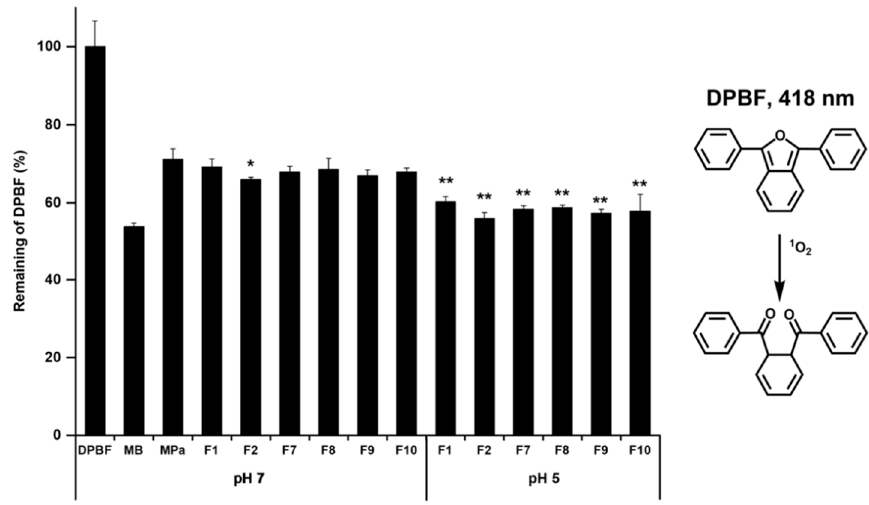
Figure 8. DPBF (50 µ M in DMSO) absorbance decay (%) for the 1 O 2 photogeneration efficacy of MPa with/without transfersome in pH 7 or pH 5 at 418 nm after photoirradiation (total light dose 2 J/cm 2 ; irradiation time 15 min). Results are expressed as means ± standard deviations of three independent experiments ( n = 3). NC: DPBF (1,3-diphenylisobenzofuran); PC: MB (methylene blue); MPa (methyl pheophorbide-a). Statistical significance of the difference in DPBF between free MPa solution and the formulations is indicated by either a single asterisk ( p < 0.05) or double asterisks ( p < 0.01).